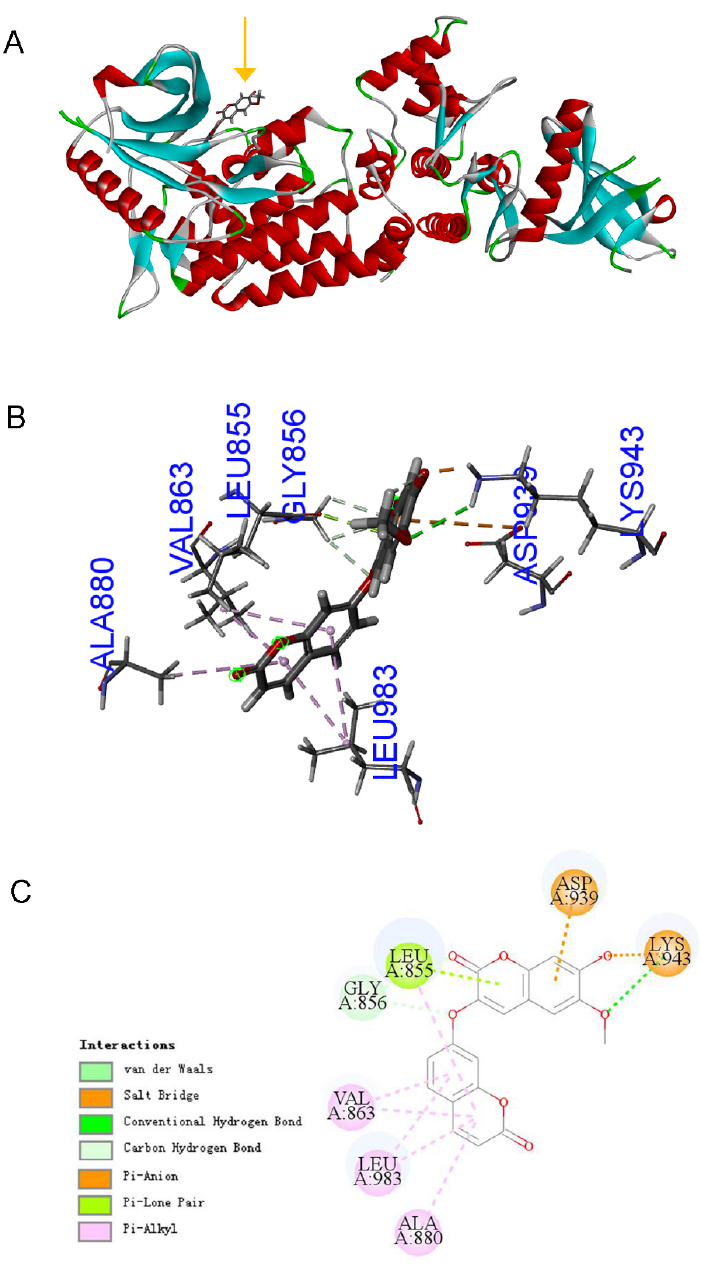
Figure 5. Molecular docking assay between DT and JAK2 (AA835–1132). A Protein surface front view of the docked DT in the JAK2 (PDB 2B7A) ( A ). The predicted position of the direct binding of DT and JAK2 ( B ). 2D representation of residues involved in DT binding with JAK2 ( C ). 2.5. Wet-Lab Experiments Prove That DT Is a JAK2 Agonist We hypothesized that DT may bind directly with JAK2 and activate the JAK2/STAT3 signal pathway to promote differentiation of OPCs from NSCs. To test this hypothesis, AG490, a specific inhibitor of the JAK2/STAT3 signal pathway, was added in NSC cultures combined with DT treatment. As shown in Figure 6A,B, 200 nM AG490 completely re- versed DT-induced differentiation, as most of these cells displayed a large and flat mor- phology. We further examined the phosphorylation of STAT3 by Western blot. As shown in Figure 6C,D, DT significantly stimulated the phosphorylation of STAT3, while AG490